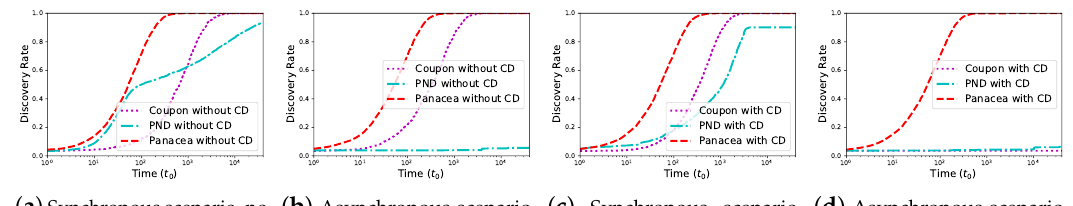
Figure 7. Panacea -NCD and Panacea -WCD achieve higher discovery rate for both synchronous and asynchronous scenarios under the uniform distribution.